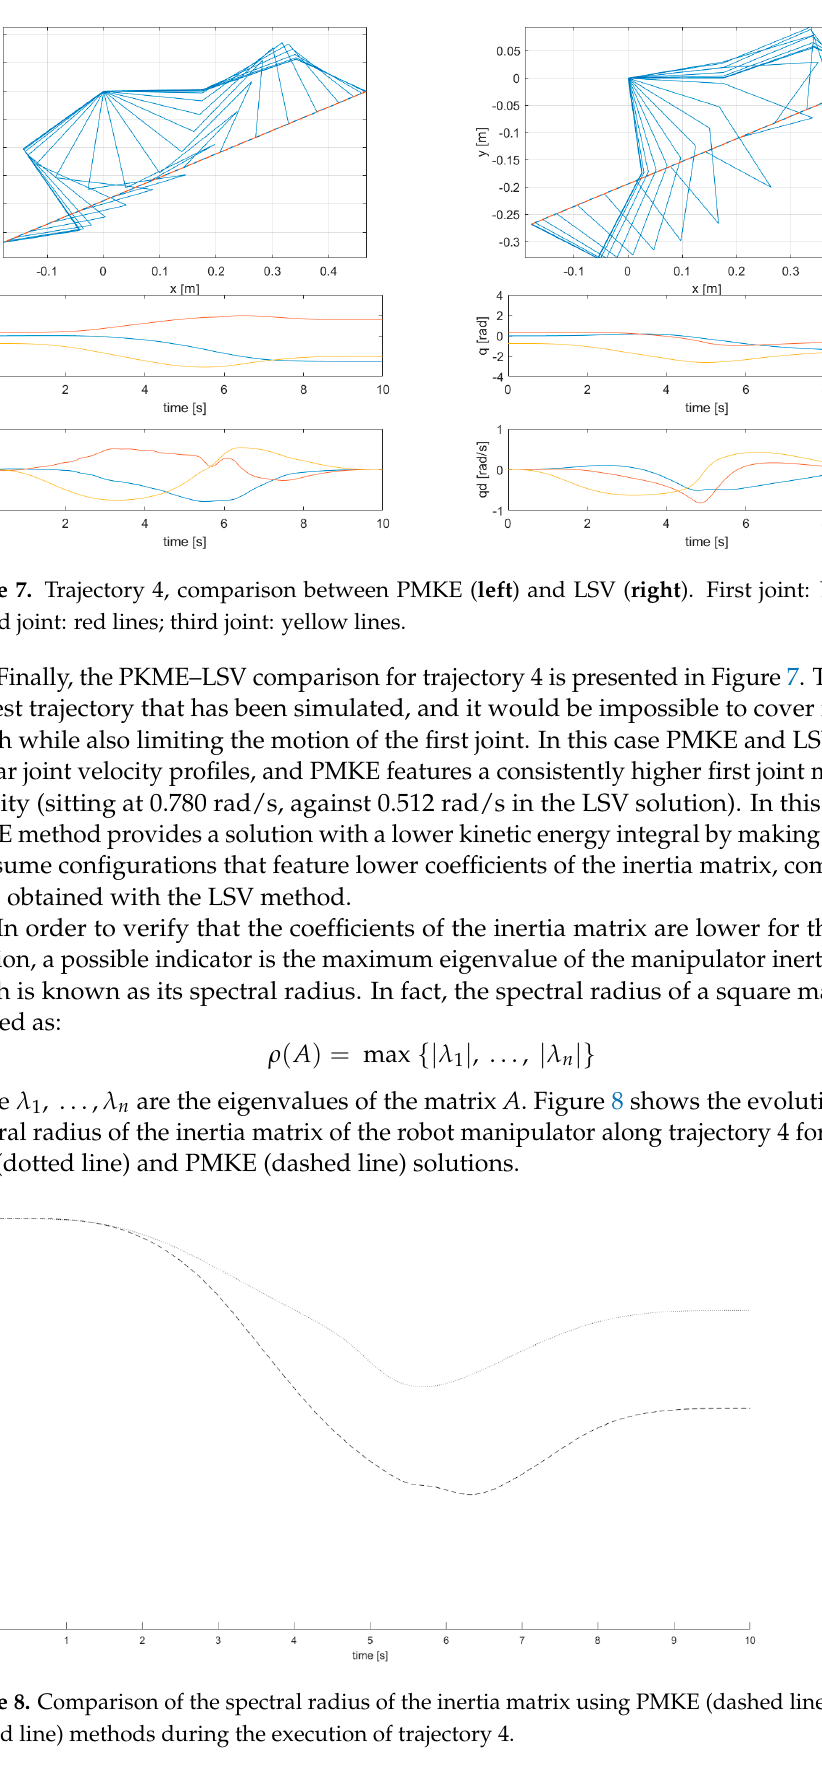
Figure 6. Trajectory 3, comparison between PMKE ( left ) and LSV ( right ). First joint: blue lines; second joint: red lines; third joint: yellow lines. Joint velocities at the singularity not shown in LSV.